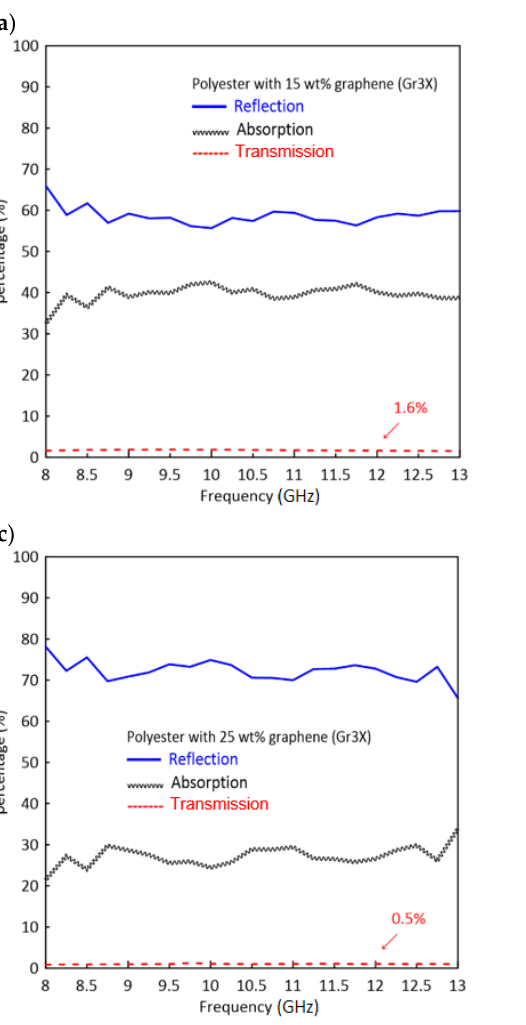
Figure 8. Reflection, absorption, and transmission coefficients of polyester loaded with ( a ) 15 wt.% Gr3x, ( b ) 20 wt.% Gr3x; ( c ) 25 wt.% Gr3x, and ( d ) 25 wt.% Gr0x. To study the effect of particle size on reflection, absorption, and overall shielding performance, we repeated the measurement with the polyester composites filled with 25 wt.% of the smaller lateral dimension filler, Gr0x. In Figure 9, the average values of 𝑆𝐸 tot , 𝑆𝐸 r , and 𝑆𝐸 a for 25 wt.% Gr0x were compared with those for 25 wt.% Gr3x.